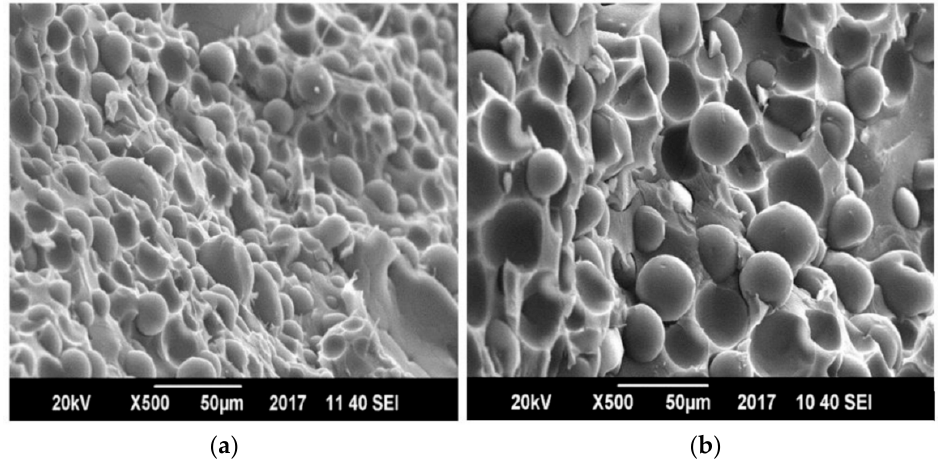
Figure 12. Scanning Electron Microscopy (SEM) images of fracture analysis of 60% PET ( a ) 5% MAH-g-PP/PET blends and ( b ) un-compatibilized PP/PET.